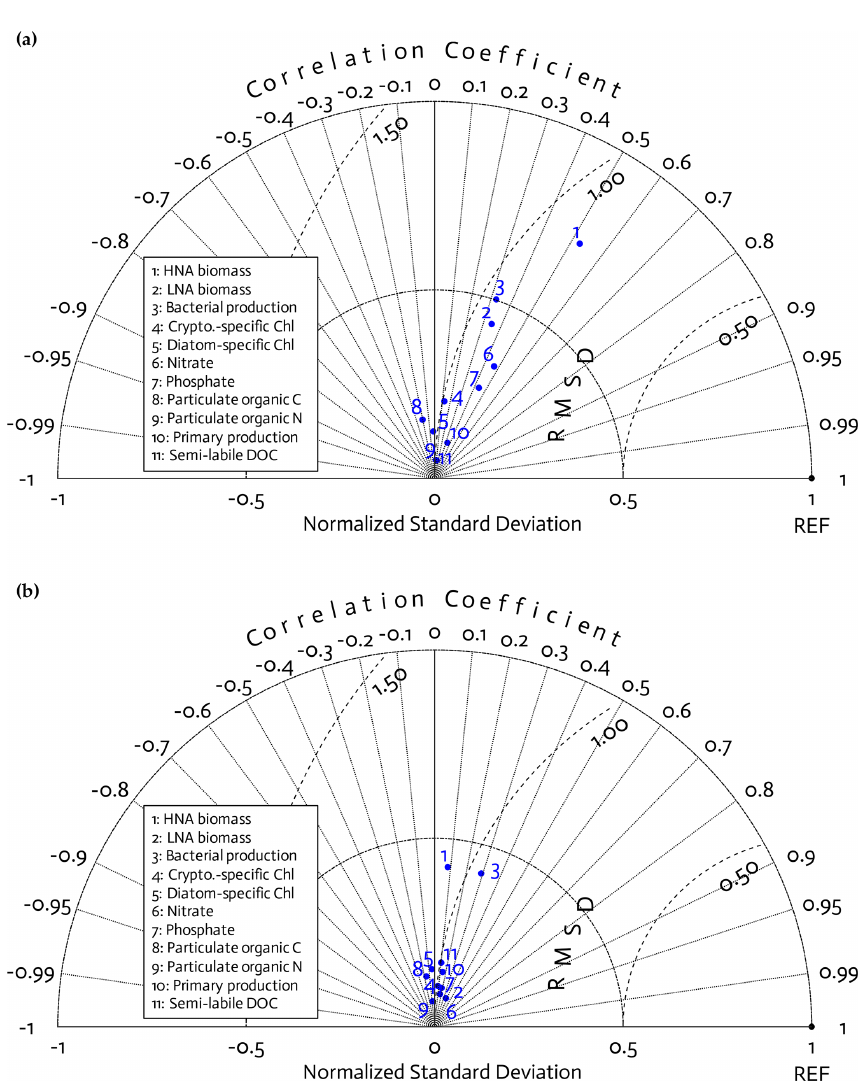
Figure 3. Model skill assessment. A Taylor diagram using a polar-coordinate system summarizing the model–observational correspondence for each model stock and flow for individual annual simulations for the 4 modeled years together (2010–11 to 2013–14; a ) and for the climatological year (b) . The angular coordinate denotes the Pearson correlation coefficient ( r ), the distance from the origin denotes the standard deviation normalized by the standard deviation of the observations, and the distance from point (1,0), marked as REF on the x axis, describes the centered (bias removed) root-mean-square difference (RMSD) between model results and